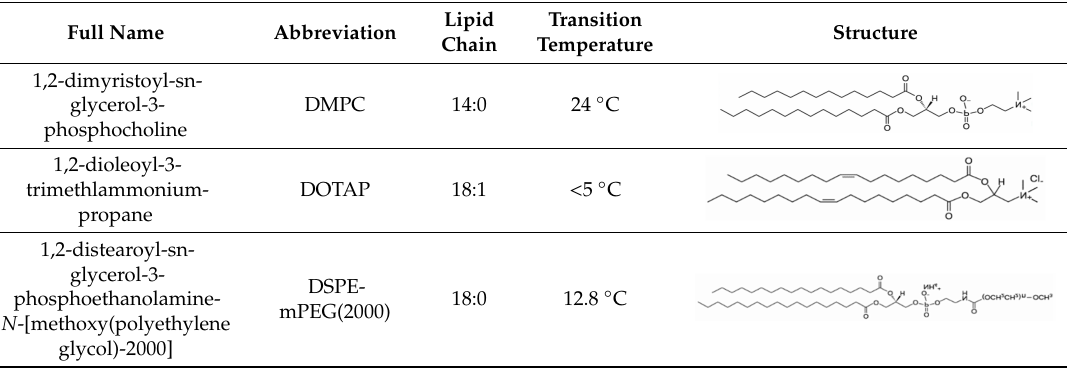
Table 1. Information of lipids used for synthesizing liposomal formulations.